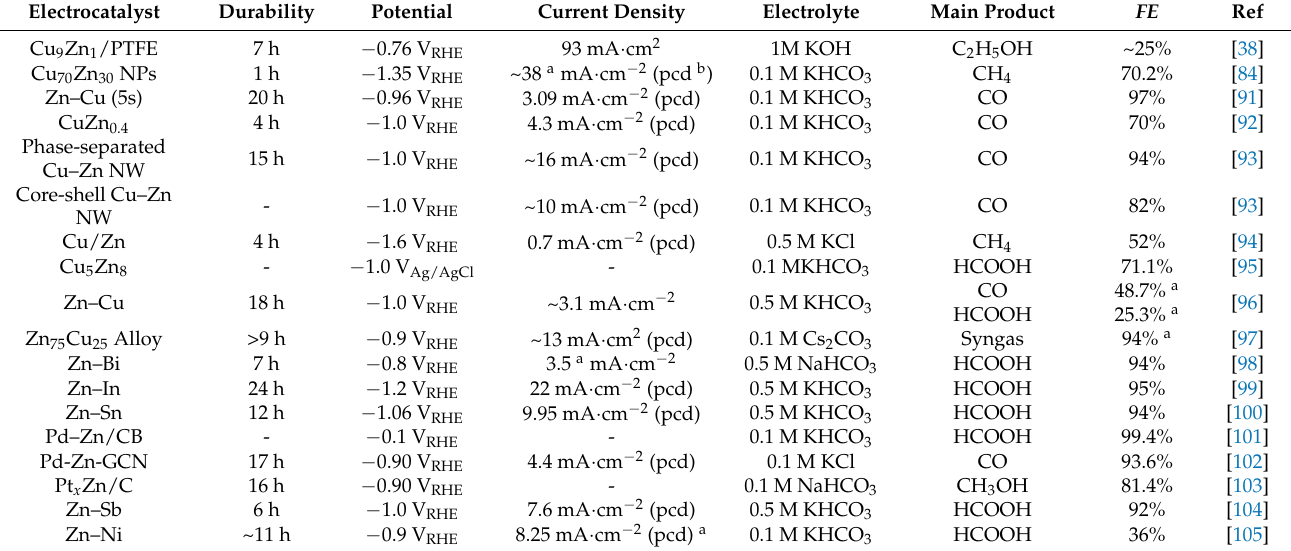
Table 3. Summarized CO 2 RR activity of Zn-based bimetallic